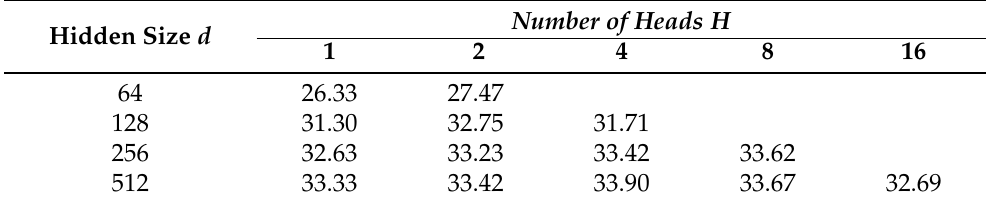
Table 1. BLEU scores comparison with various hidden size d and number of head H on IWSLT17 De → En corpus.